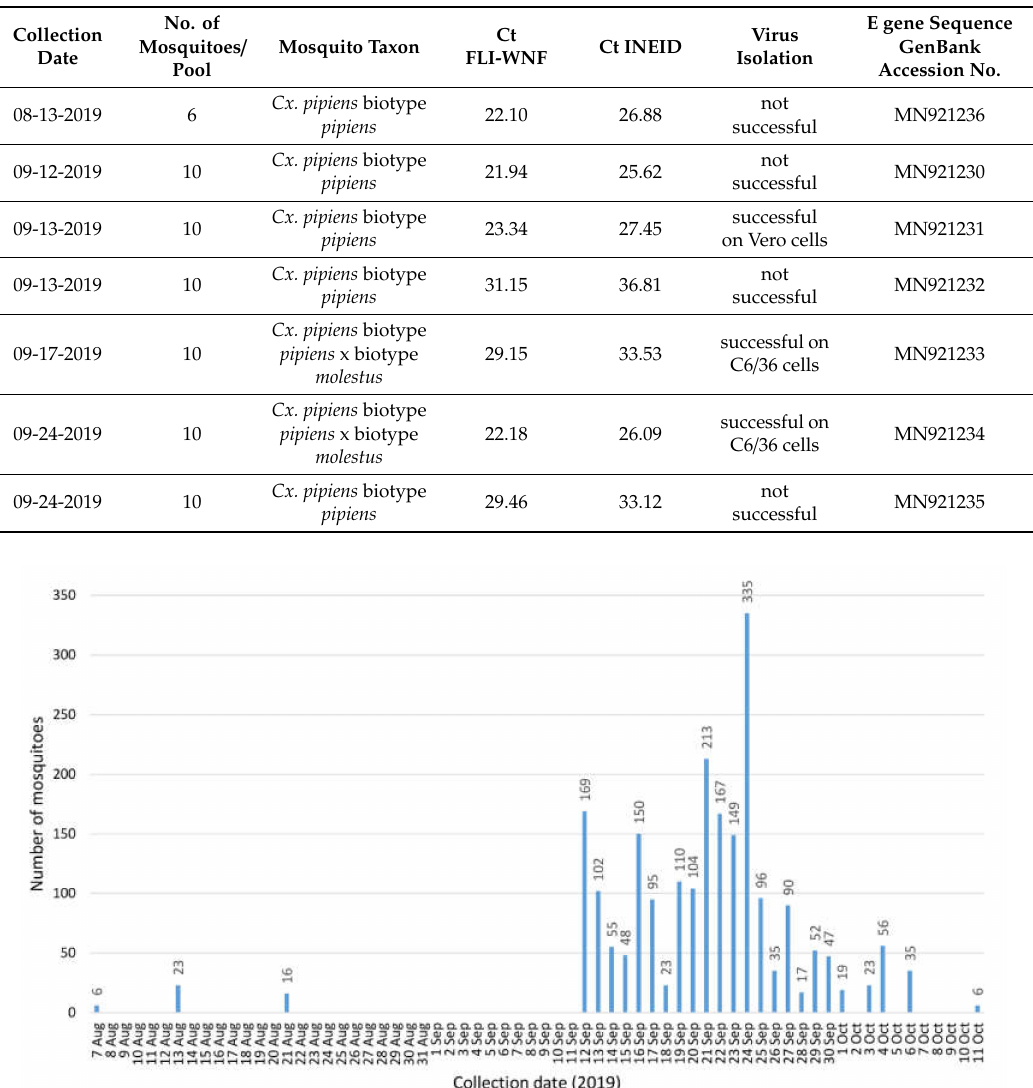
Table 2. Collection dates and Ct values of mosquitoes from the Tierpark Berlin belonging to the Culex pipiens complex that tested positive in two WNV-specific qRT-PCR assays (FLI-WNF, INEID; names of assays refer to primer names in the original paper [50]).